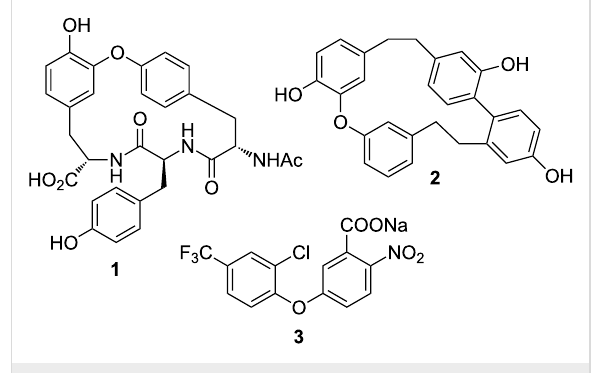
Figure 1: Illustration of synthetically interesting diaryl